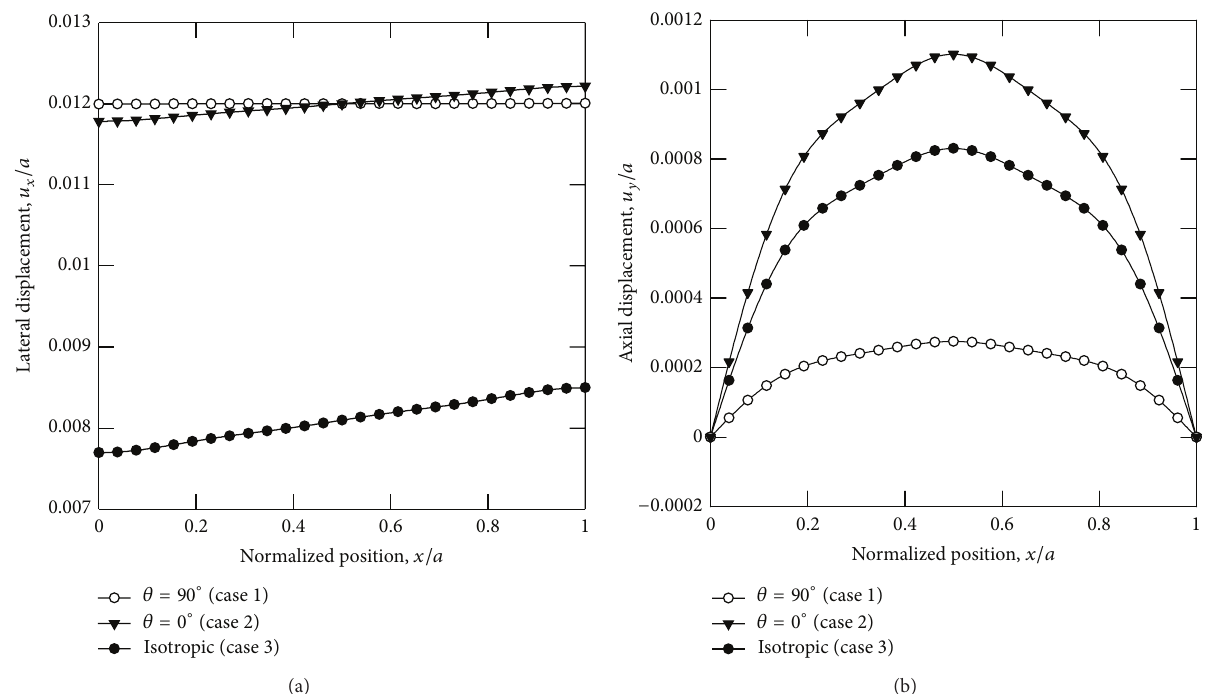
Figure 3: Effect of fiber orientation and material isotropy on the normalized displacement components at the section 𝑦/𝑏 = 1.0 of the panel: (a) lateral displacement; (b) axial displacement.